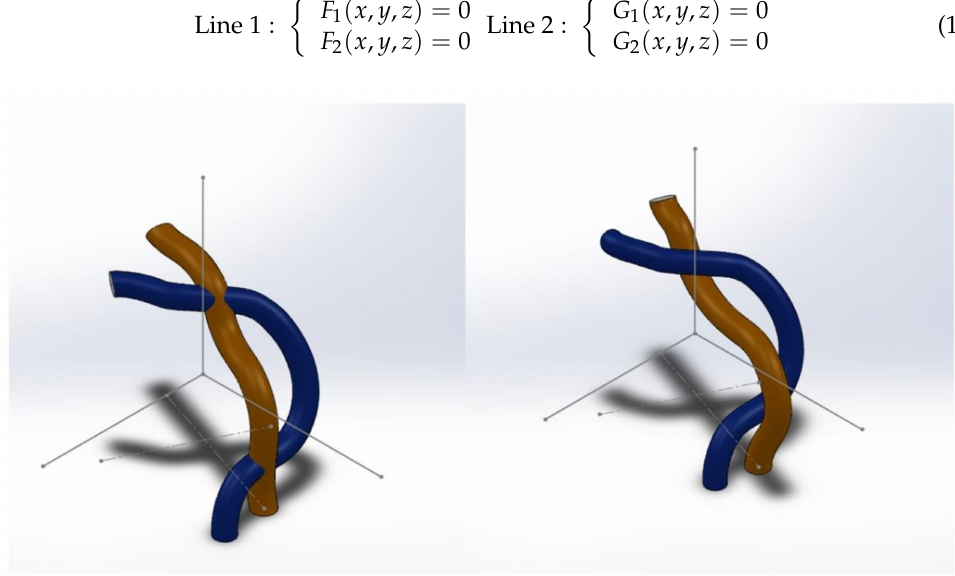
Figure 20. Intersection of two lines in three-dimensional